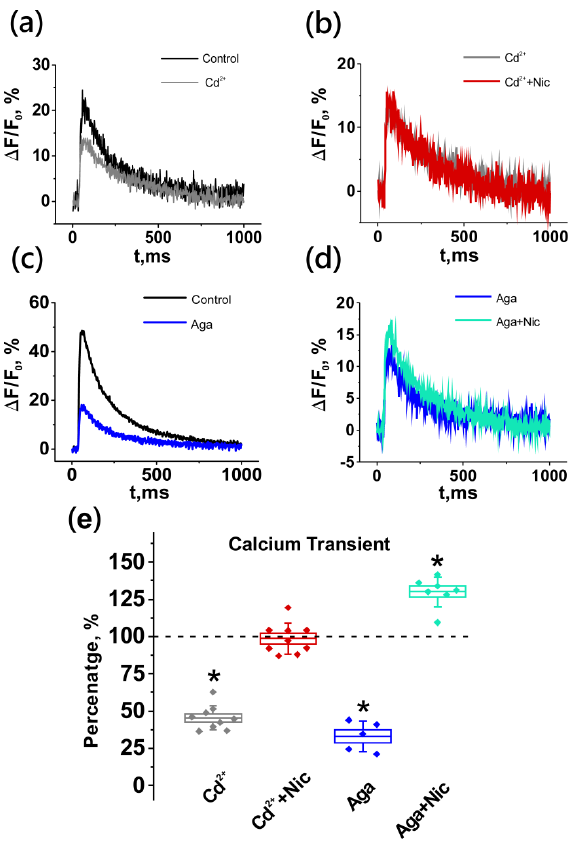
Figure 5. The calcium transient-enhancing effect of nicotine is abolished after a nonspecific calcium channel blockade, but not after inhibition of Ca v 2.1-type calcium channels. Panels on the top are representative traces of calcium transient from individual experiments: ( a ) the effect of the nonspecific calcium channel blocker CdCl 2 (Cd 2+ , 10 µ M), ( b ) no effect of nicotine (Nic, 10 µ M) after pretreatment with CdCl 2 , ( c ) the effect of the Ca v 2.1 VGCC blocker ω -agatoxin IVA (Aga, 40 nM), and ( d ) the effect of nicotine on the calcium transient after pre-incubation with ω -agatoxin IVA. ( e ) Mean ± SEM and SD of calcium signal amplitudes obtained in the above series and expressed as a percentage of control or value after CdCl 2 ( n = 9), CdCl 2 + Nic ( n = 9), Aga ( n = 5;) and Aga + Nic ( n = 7) application. Asterisks (*) indicate significant effects ( p < 0.05, one-way repeated ANOVA test). The application of the specific P/Q-type (Ca v 2.1) VGCCs blocker ω -agatoxin IVA